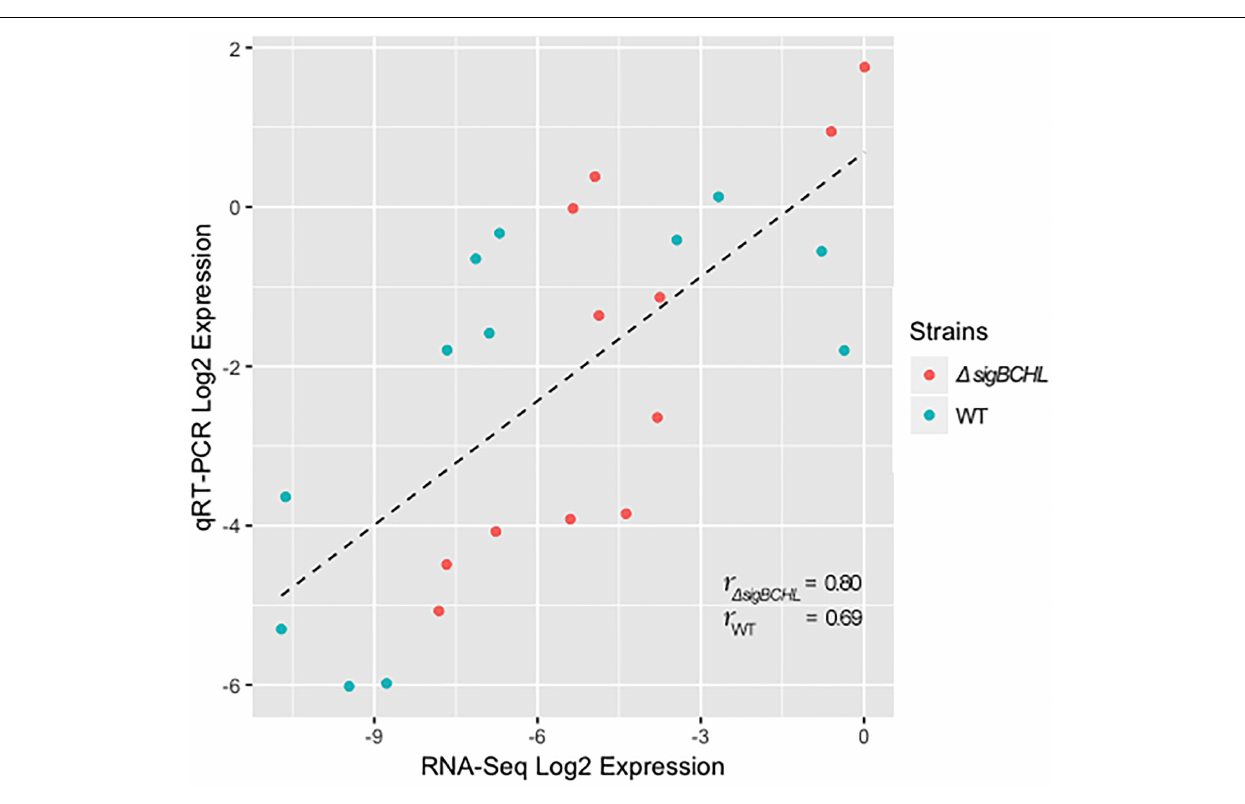
FIGURE 4 | Pearson correlation between RNA-seq and qPCR for DEGs of L. monocytogenes wild type (blue) and quadruple mutant (red). All expression data were transformed to Log 2 and normalized by geometric mean of housekeeping genes ( rpoB and bglA